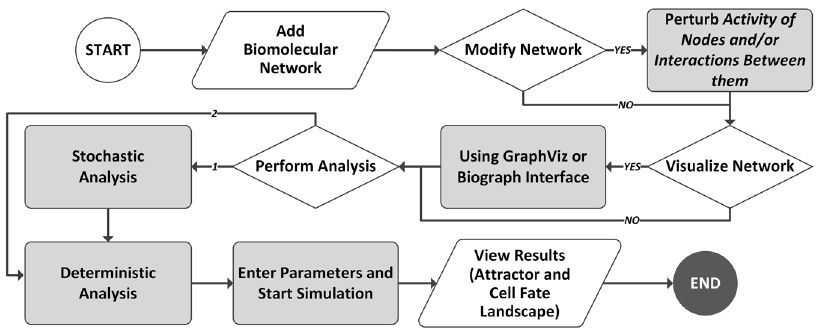
Figure 2. Workflow of ATLANTIS. The salient steps in the attractor landscape construction and cell fate prediction process include data input, model analysis and result